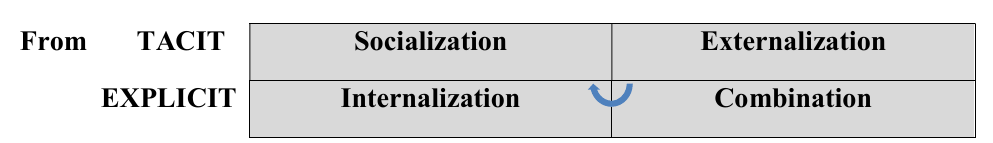
Fig. 2. A dynamic theory of organizational knowledge (Nonaka,